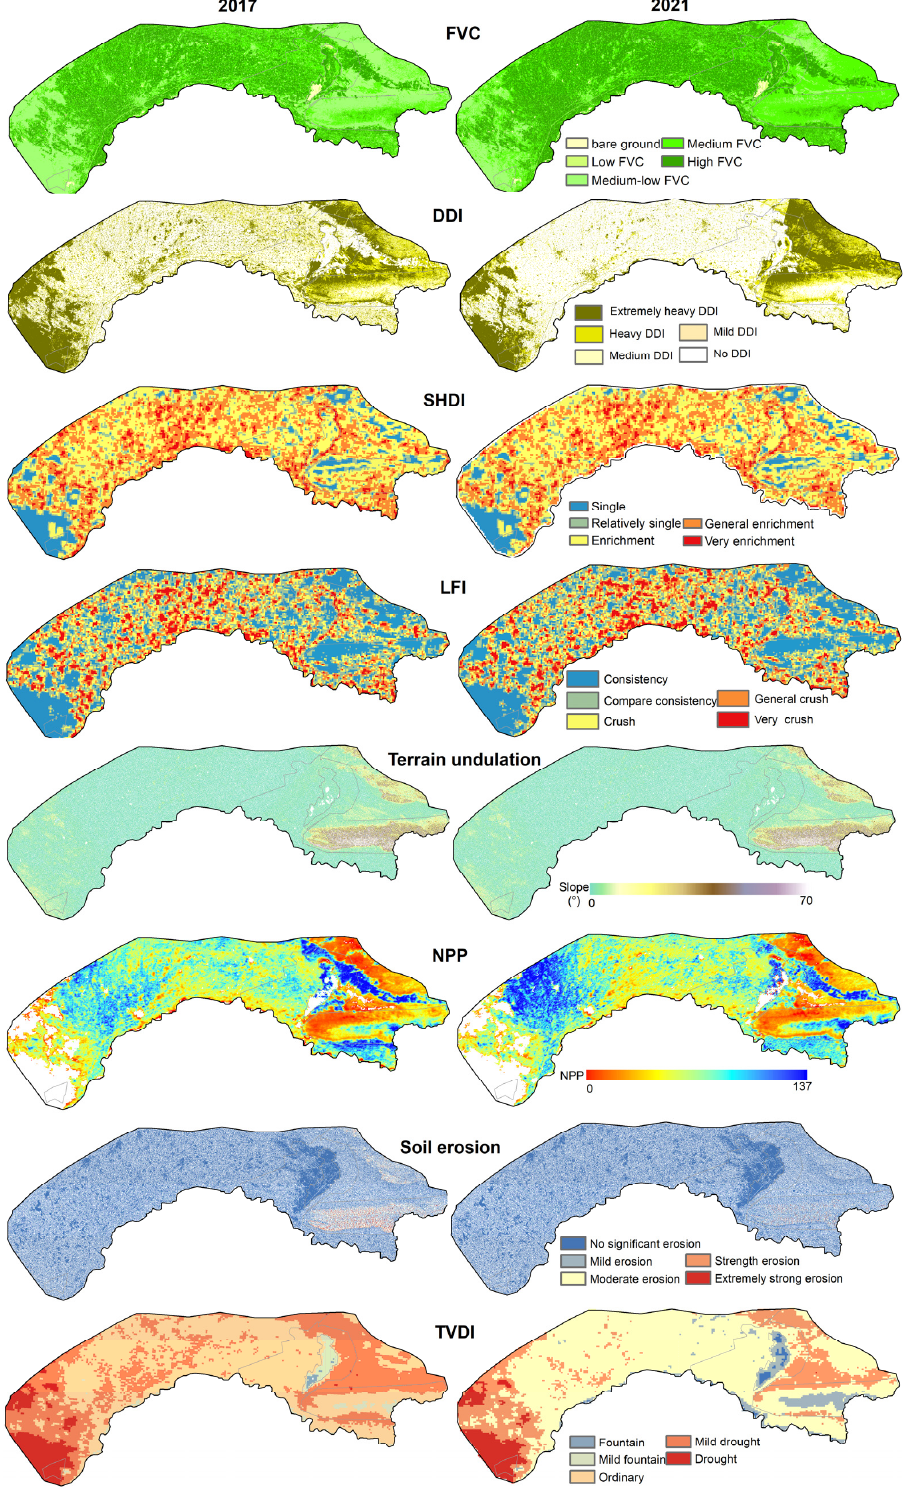
Figure 2. Schematic diagram of the results of ecological restoration effect assessment indicators in the Wuliangsuhai watershed.